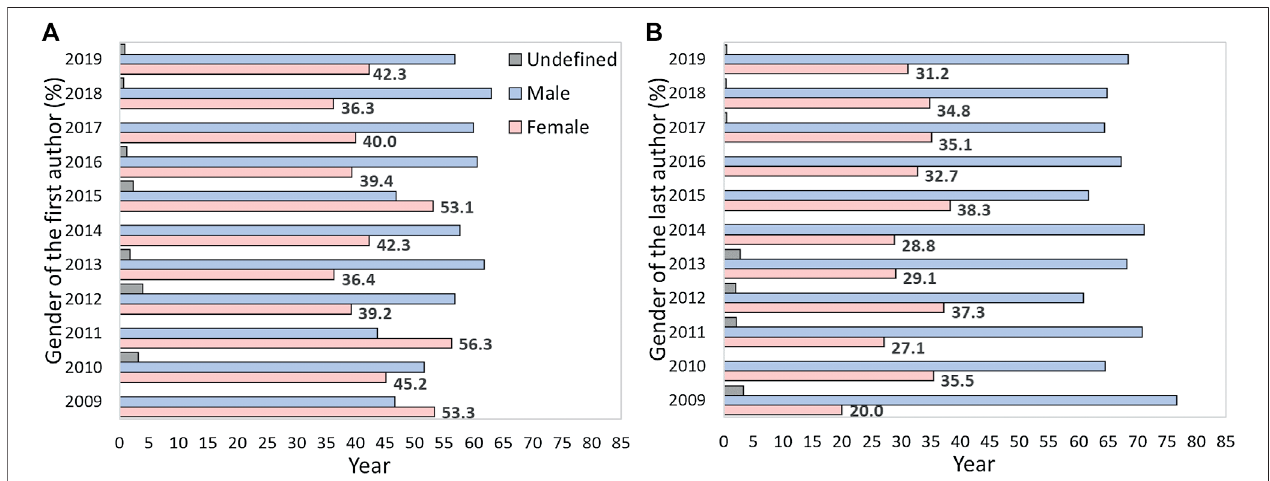
FIGURE 4 | Gender distribution of publications with European authors in the last decade (2009 – 2019): (A) fi rst author and (B) last author in the publication author lists.